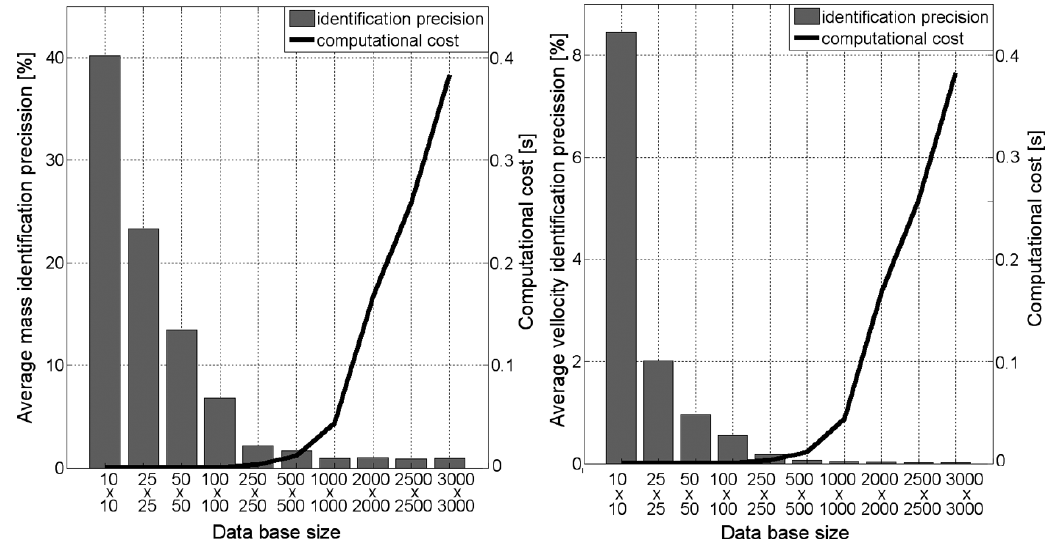
Fig. 15. Identi fi cation error and time as functions of database size: mass identi fi cation (left), velocity identi fi cation